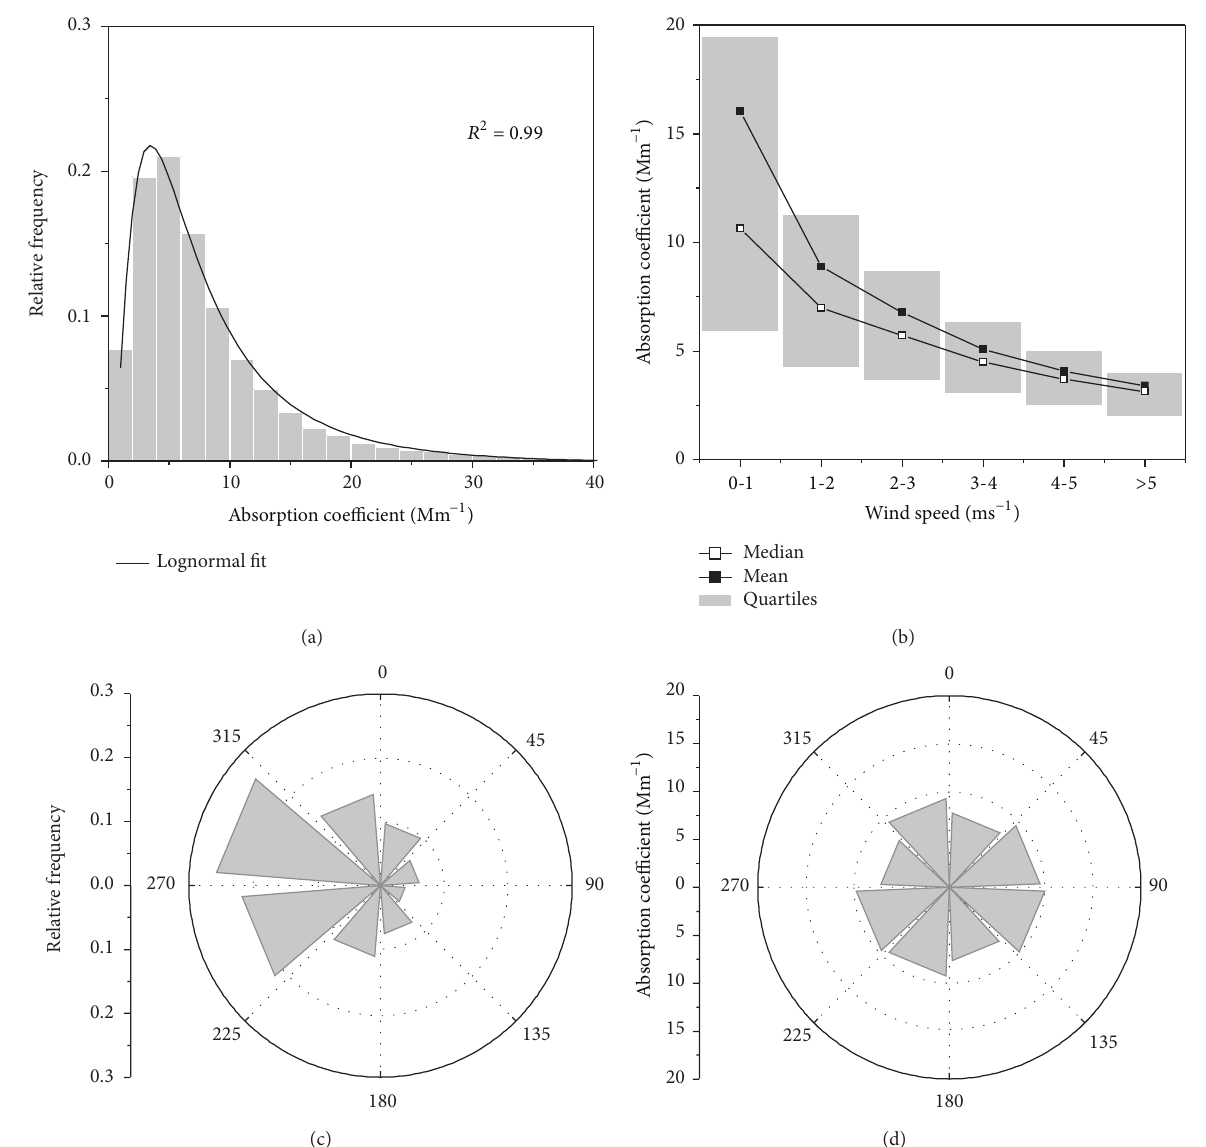
Figure 3: Relative frequency distributions of the hourly (a) absorption coefficient, with the respective lognormal fitting, and (b) wind direction. Absorption coefficient as function of (c) wind speed (including the quartiles) and (d) wind